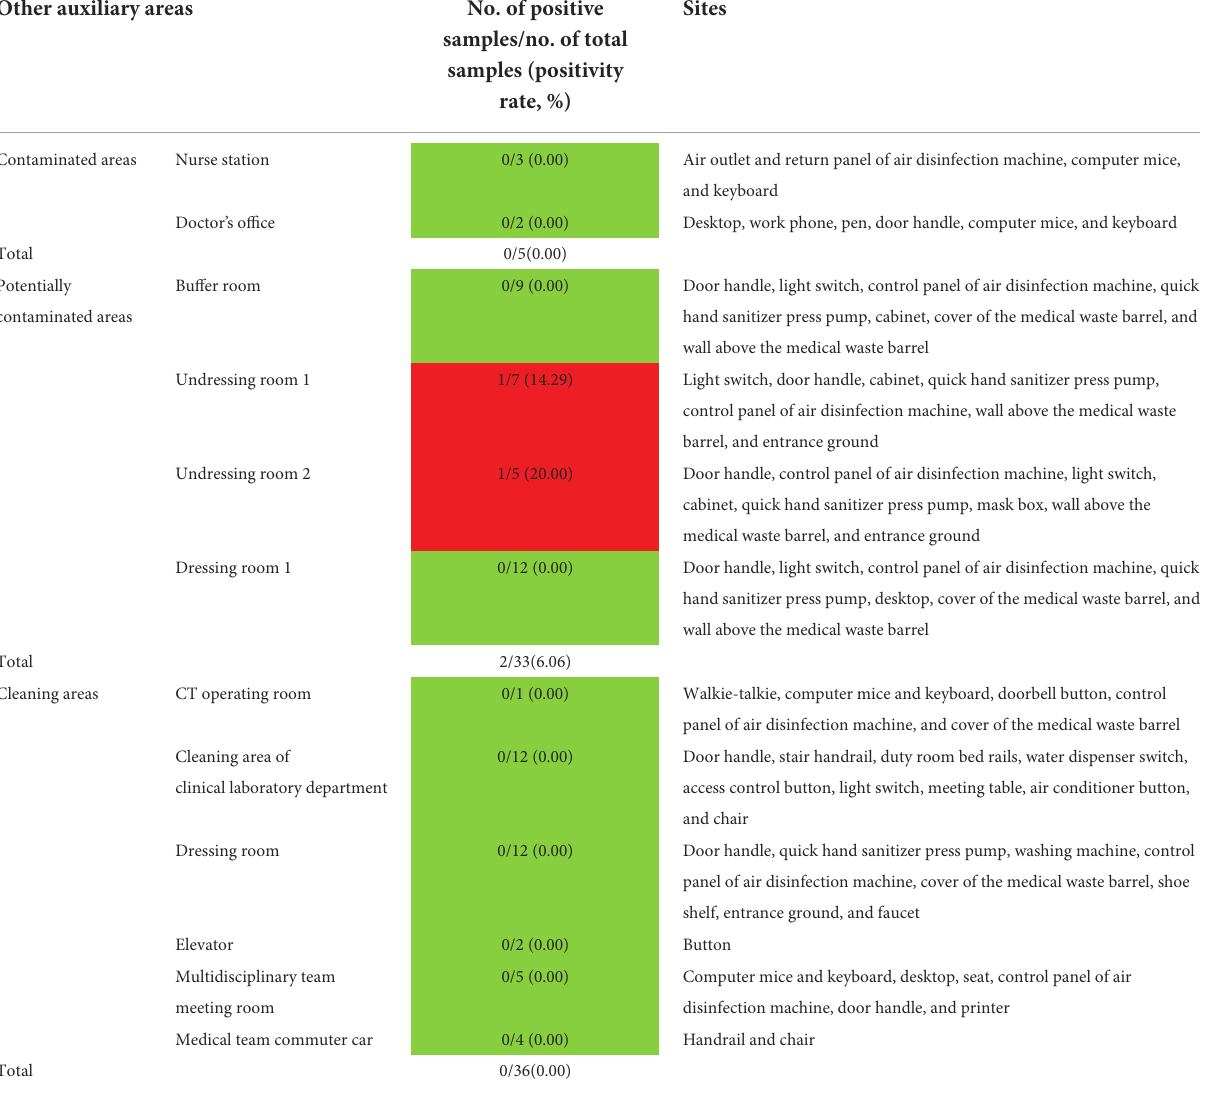
TABLE 3 Results of SARS-CoV-2 testing from other auxiliary areas before intervention. Other auxiliary